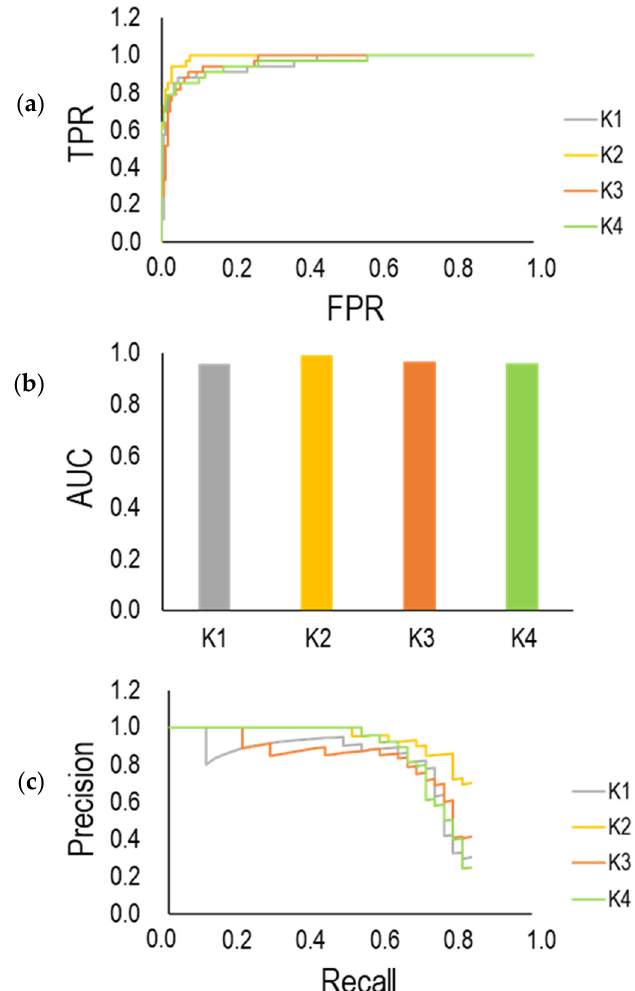
Figure 17. ( a ) ROC curve; ( b ) AUC; ( c ) precision-recall curve after reducing the imbalance between the number of datasets between groups A and B through oversampling of group B datasets.